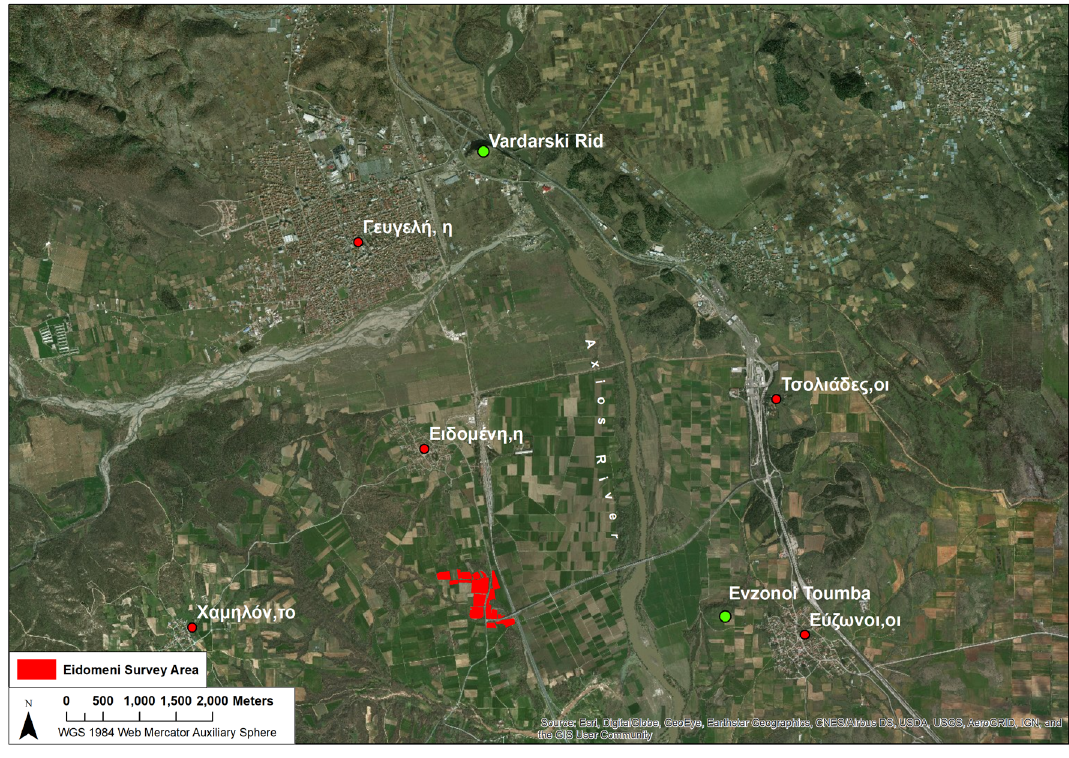
Figure 6. The prehistoric habitation in the broader landscape surrounding the survey area (WGS 1984, WebMercator Auxiliary